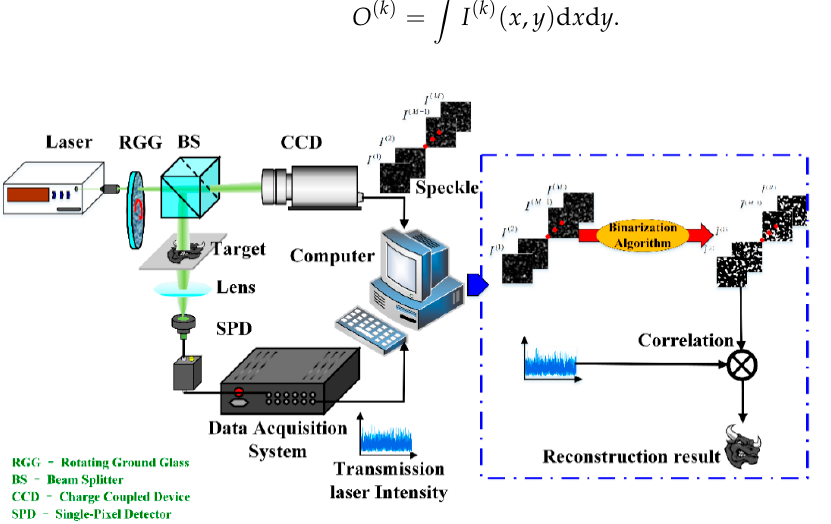
Figure 1. The schematic of BGI system.